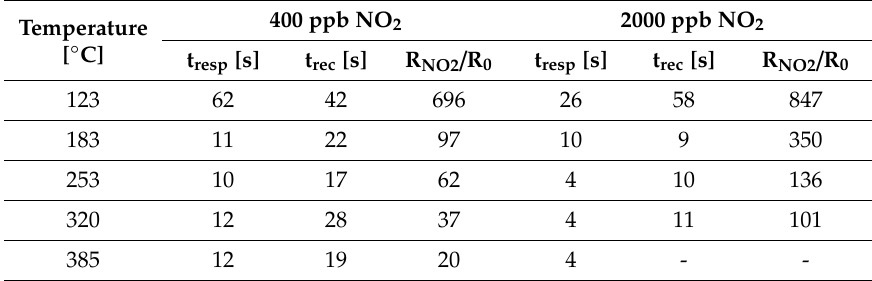
Table 2. Kinetics of the SnO 2 /TiO 2 thin film response to NO 2 of two different concentrations; t resp —response time, t rec —recovery time.